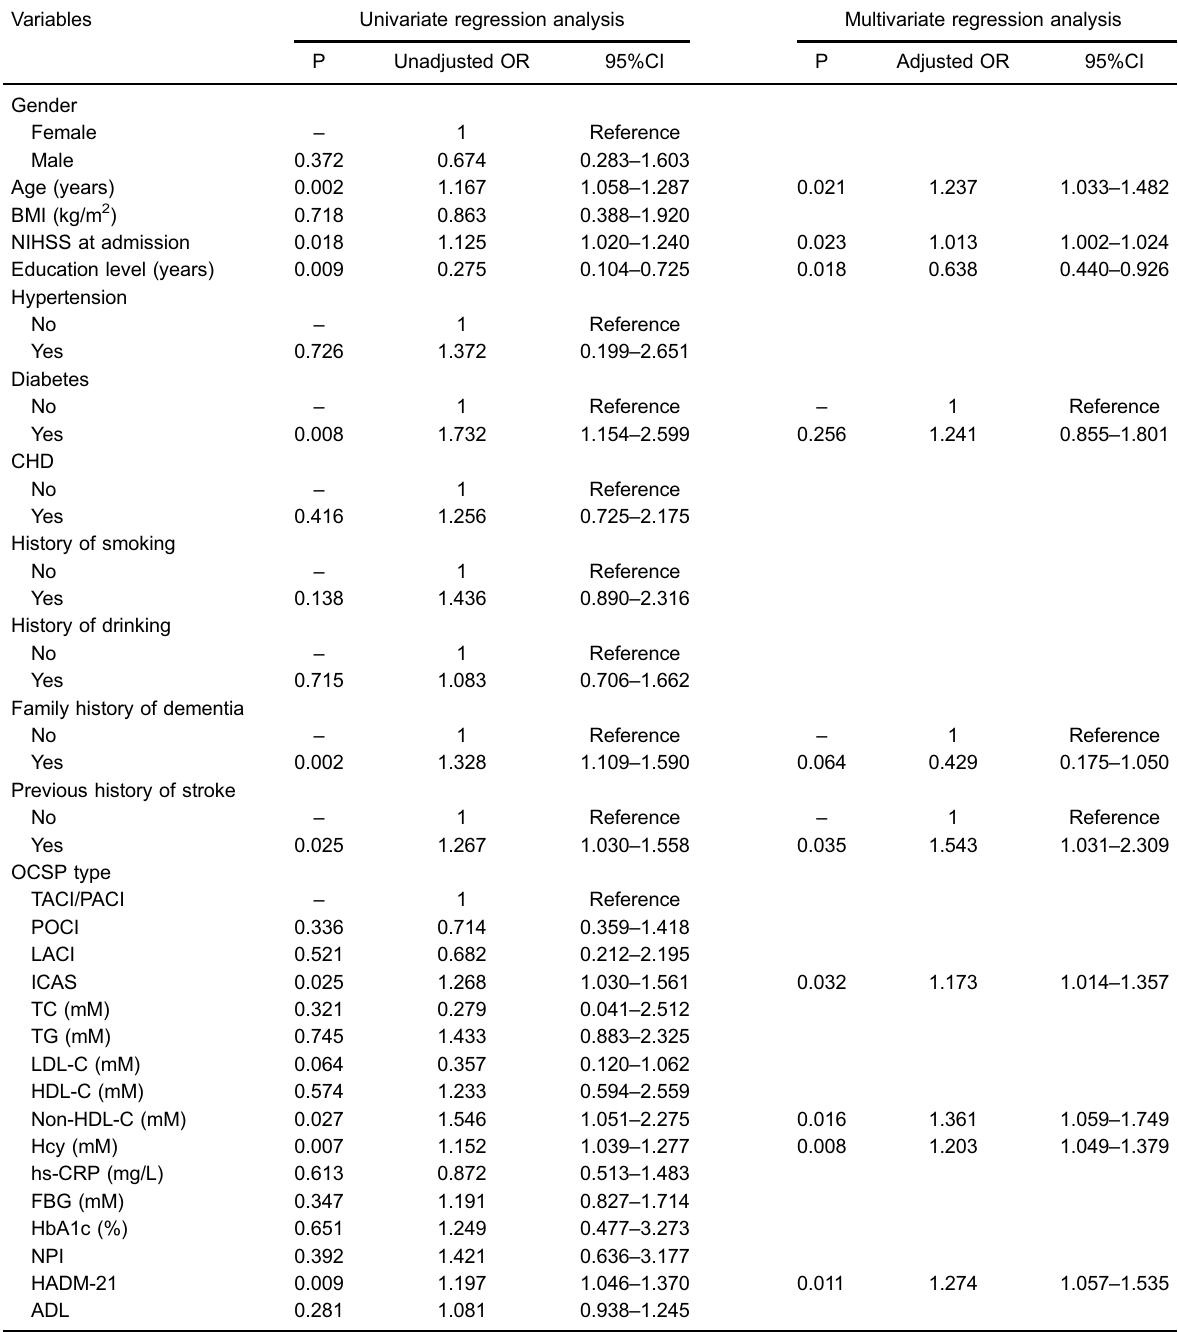
Table 5. Logistic regression analyses of the factors that affected cognitive disorder after acute ischemic